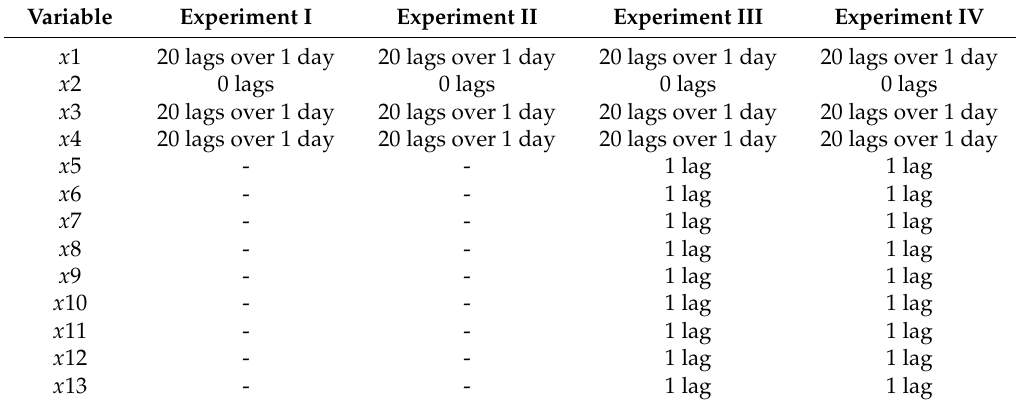
Table 6. Description of the lags used.